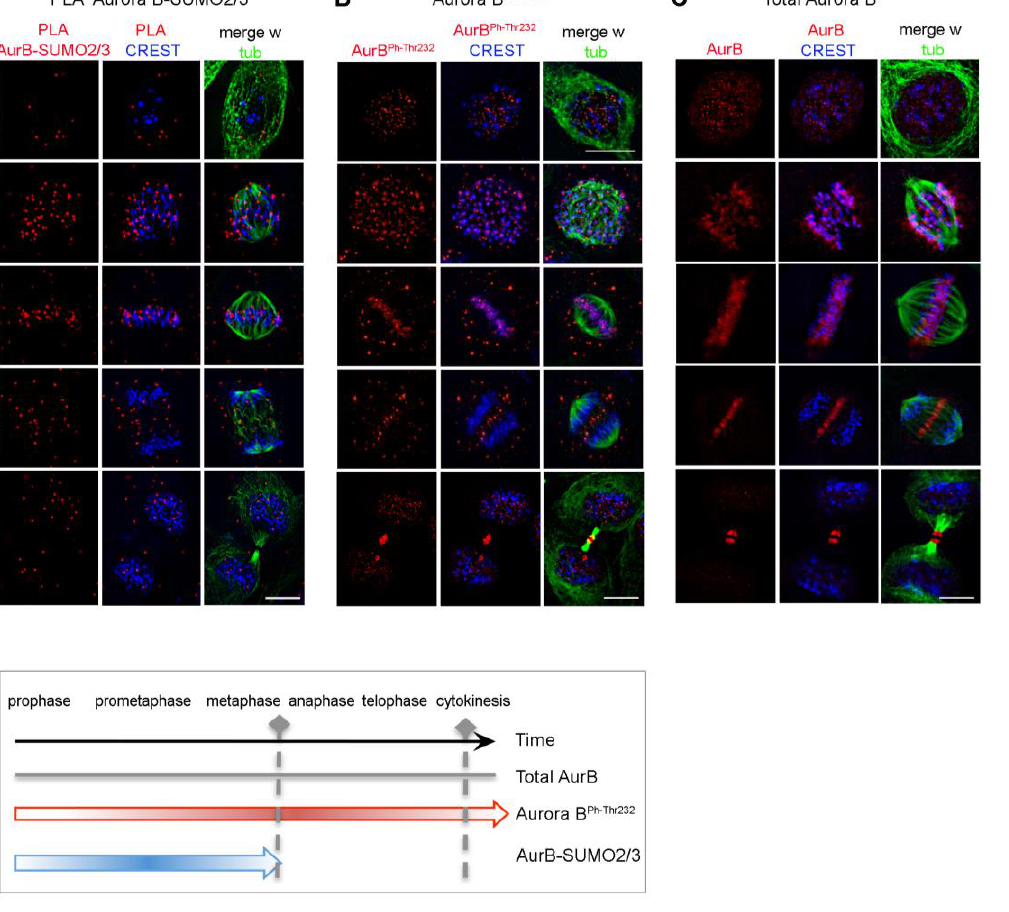
Figure 2. Distribution of Aurora B-SUMO2/3 PLA products in mitotic cells in situ. ( A ) Aurora B-SUMO2/3 PLA signals (red) co-localise with kinetochores (CREST, blue) in prometaphase and metaphase, and decrease abruptly in anaphase/telophase. ( B ) Localisation of active Aurora B, auto- phosphorylated at Thr232. ( C ) Canonical localisation of the total Aurora pool (red) at kinetochores (CREST, blue) and midbody (alpha-tubulin, green) during mitotic progression. Bar, 10 µm. ( D ) The schematics summarises the temporal distribution of Aurora B forms during mitotic progression.